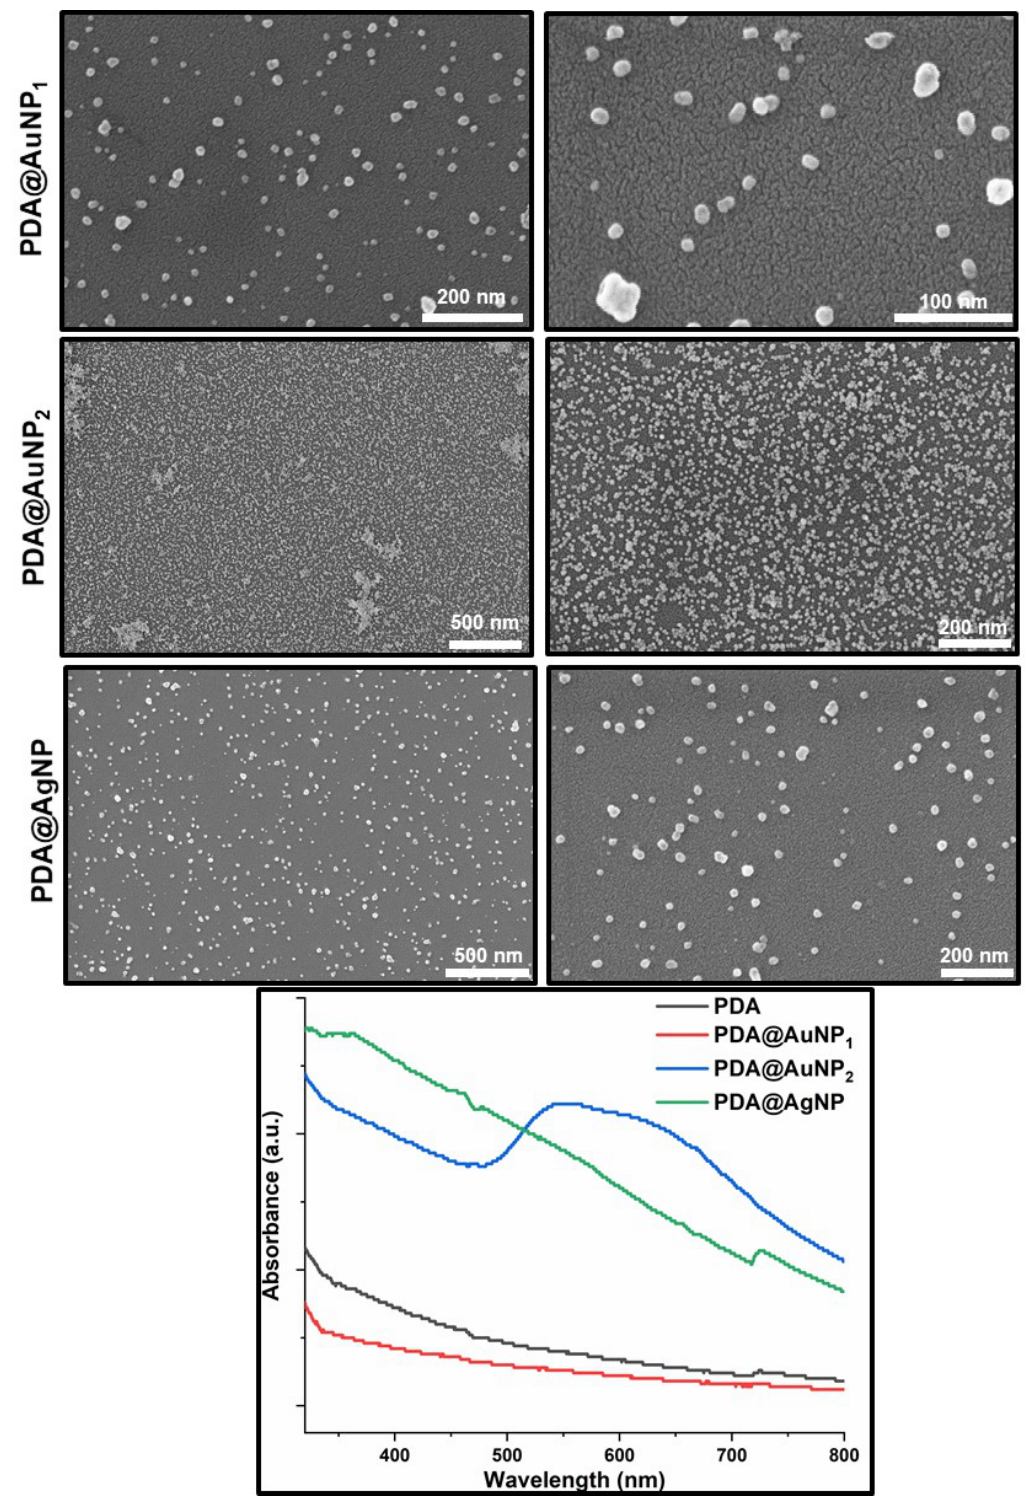
Figure 2. SEM images of PDA@AuNP 1 , PDA@AuNP 2 , and PDA@AgNP thin films and their relevant UV-Vis absorption spectra.